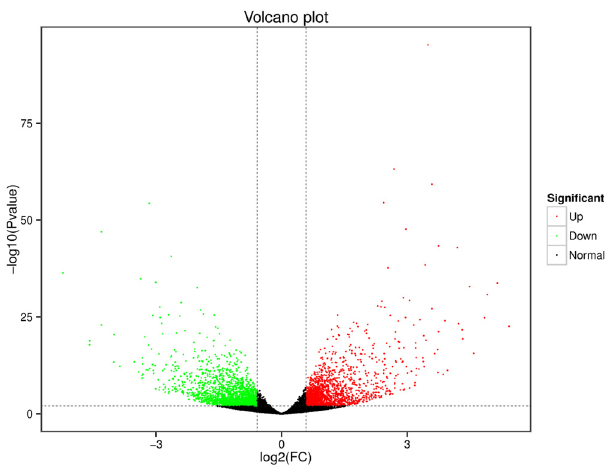
Figure 4. Results of DEGs. Each dot represents a gene. Green and red dots represent down- and up-regulated genes, respectively. The greater the absolute value of the abscissa was, the difference between challenge group and control group was more obvious. Similarly, the bigger the ordinate value was, the more significant the gene expression difference between the two groups.